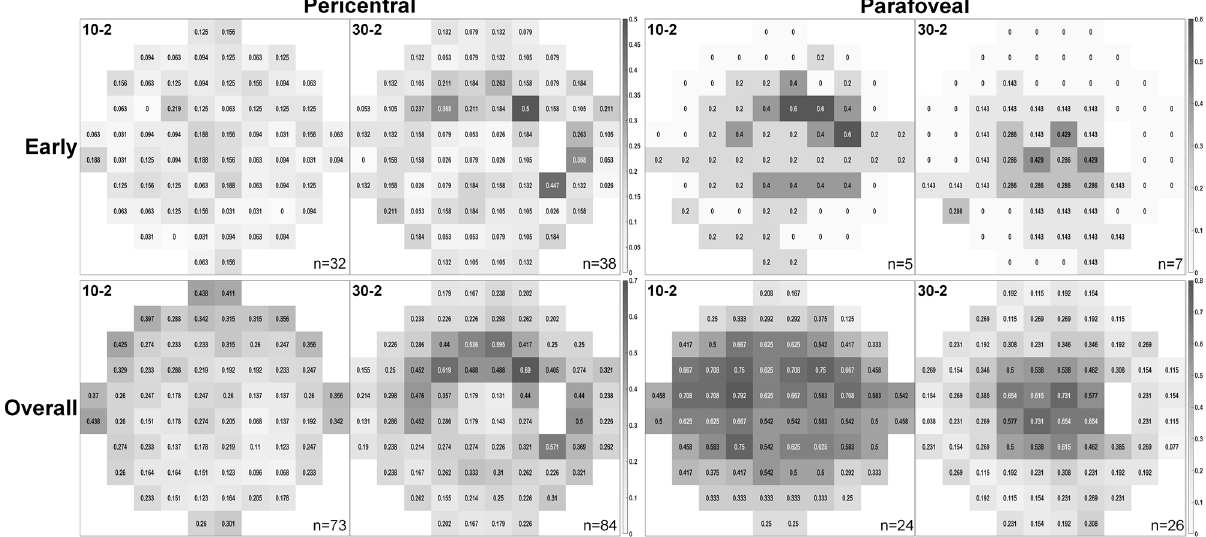
Figure 2. Pointwise frequency map of scotoma for pattern deviation maps of 10-2 and 30-2 tests in early and overall eyes with hydroxychloroquine retinopathy. Probabilities (the proportion of eyes showing abnormality at each test location in the 10-2 and 30-2 tests among those tested with each of the VF strategies) are indicated as numbers within each test point and also represented by using grayscale in each group of parafoveal and pericentral retinopathy among overall and early cases. The numbers in the lower right corner indicate the sample sizes (n) for the frequency